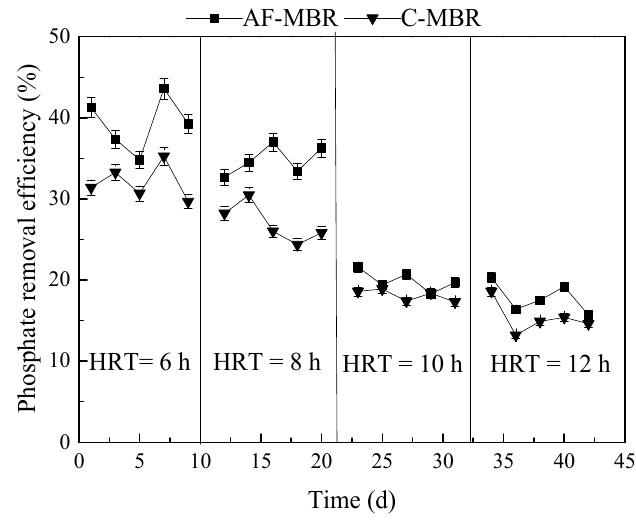
Figure 3. Influence of different HRTs on phosphate removal efficiency.